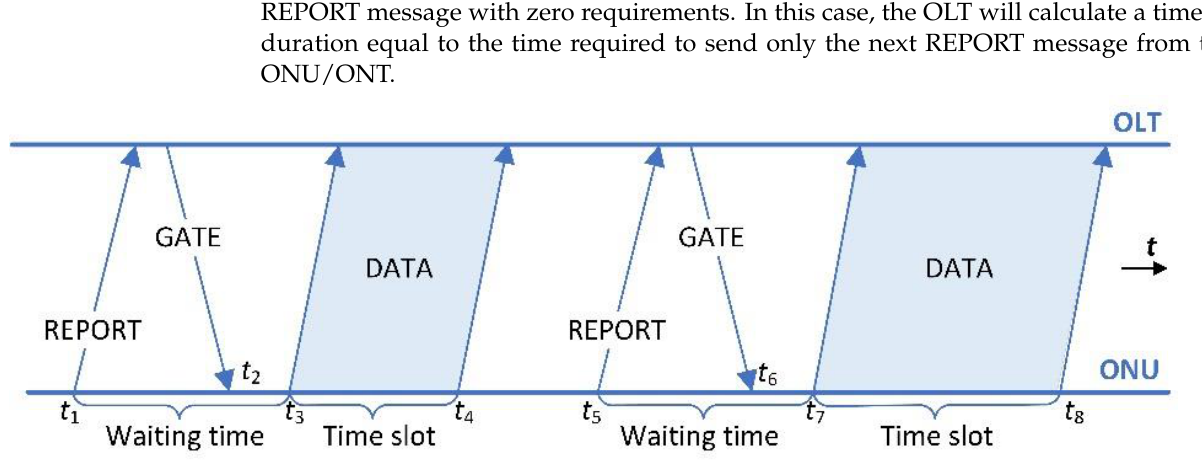
Figure 7. Example of REPORT and GATE messages to define ONU-timeslot durations. Various methods (services) have been proposed to determine the timeslot duration of each